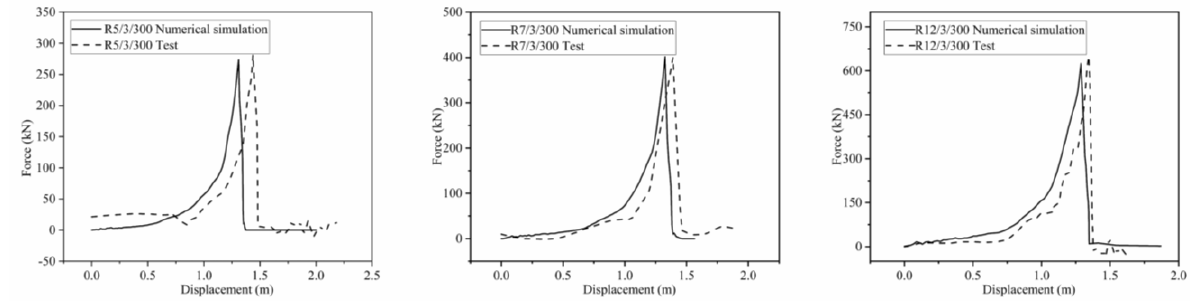
Figure 14. Comparison of experimental and numerical simulation results in the dynamic shock test.